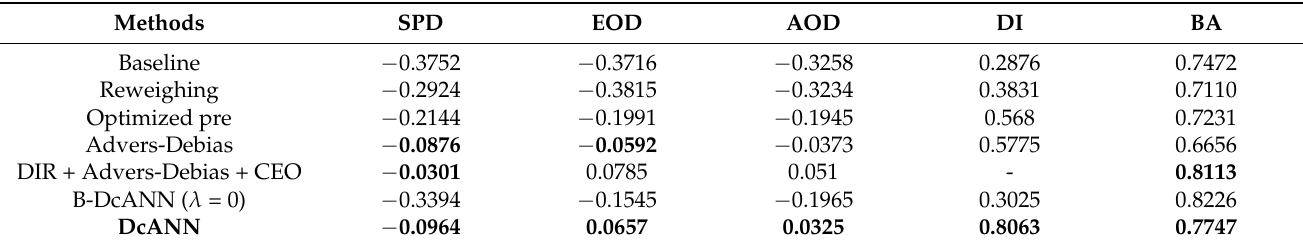
Table 3. Fairness scores and balanced accuracies of predictions for gender-biased adult dataset for different models.